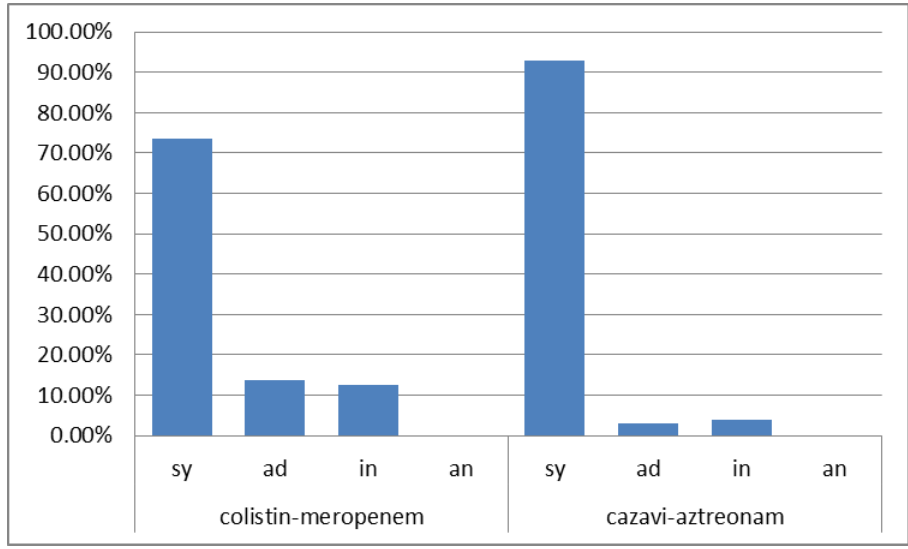
Figure 2. The % results of antimicrobial combinations tested for K. pneumoniae . cazavi: